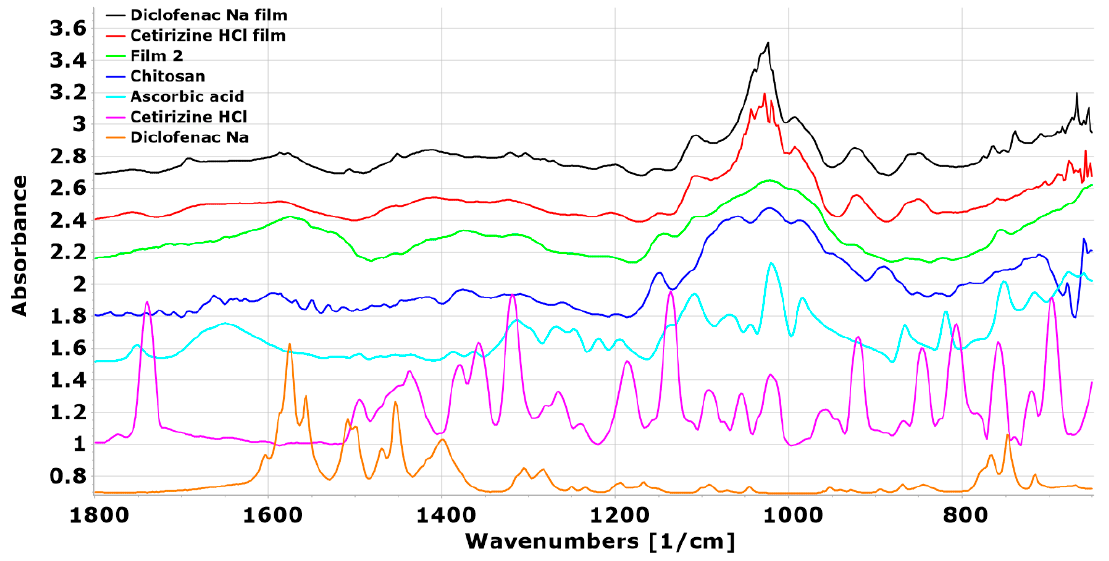
Figure 11. FTIR spectra of chitosan, ascorbic acid, and the films containing active agents (cetirizine HCl, diclofenac Na).